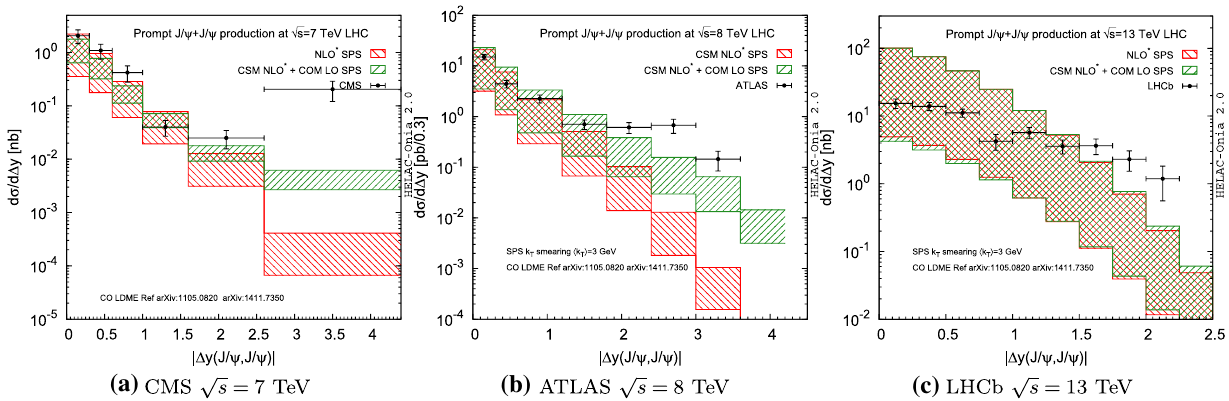
√ s = 7 , 8 , 13 TeV, respectively,